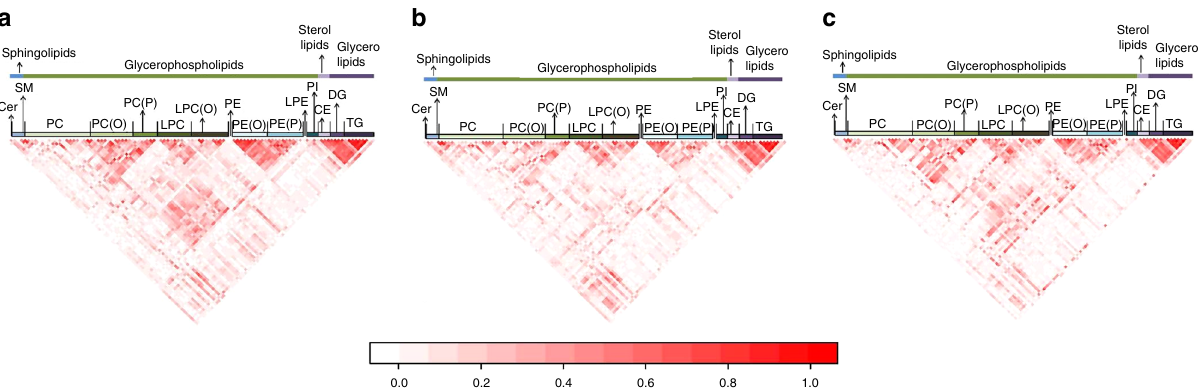
Fig. 4 Correlation heatmap of the 282 lipids in each ethnic group. The correlation heatmap between 282 lipids in the a Chinese; b Malays; and c Indians. The correlation was calculated by using concentration of the lipids via Pearson ’ s correlation, r 2 . The lipids are fi rst categorized into lipid category and followed by lipid classes. In each of the lipid class, the lipid species are ordered according to their carbon chain length and degree of unsaturation (number of double bonds). The intensity of the color re fl ects the magnitude of the correlation, in which the white color means r 2 = 0 and red color means r 2 =